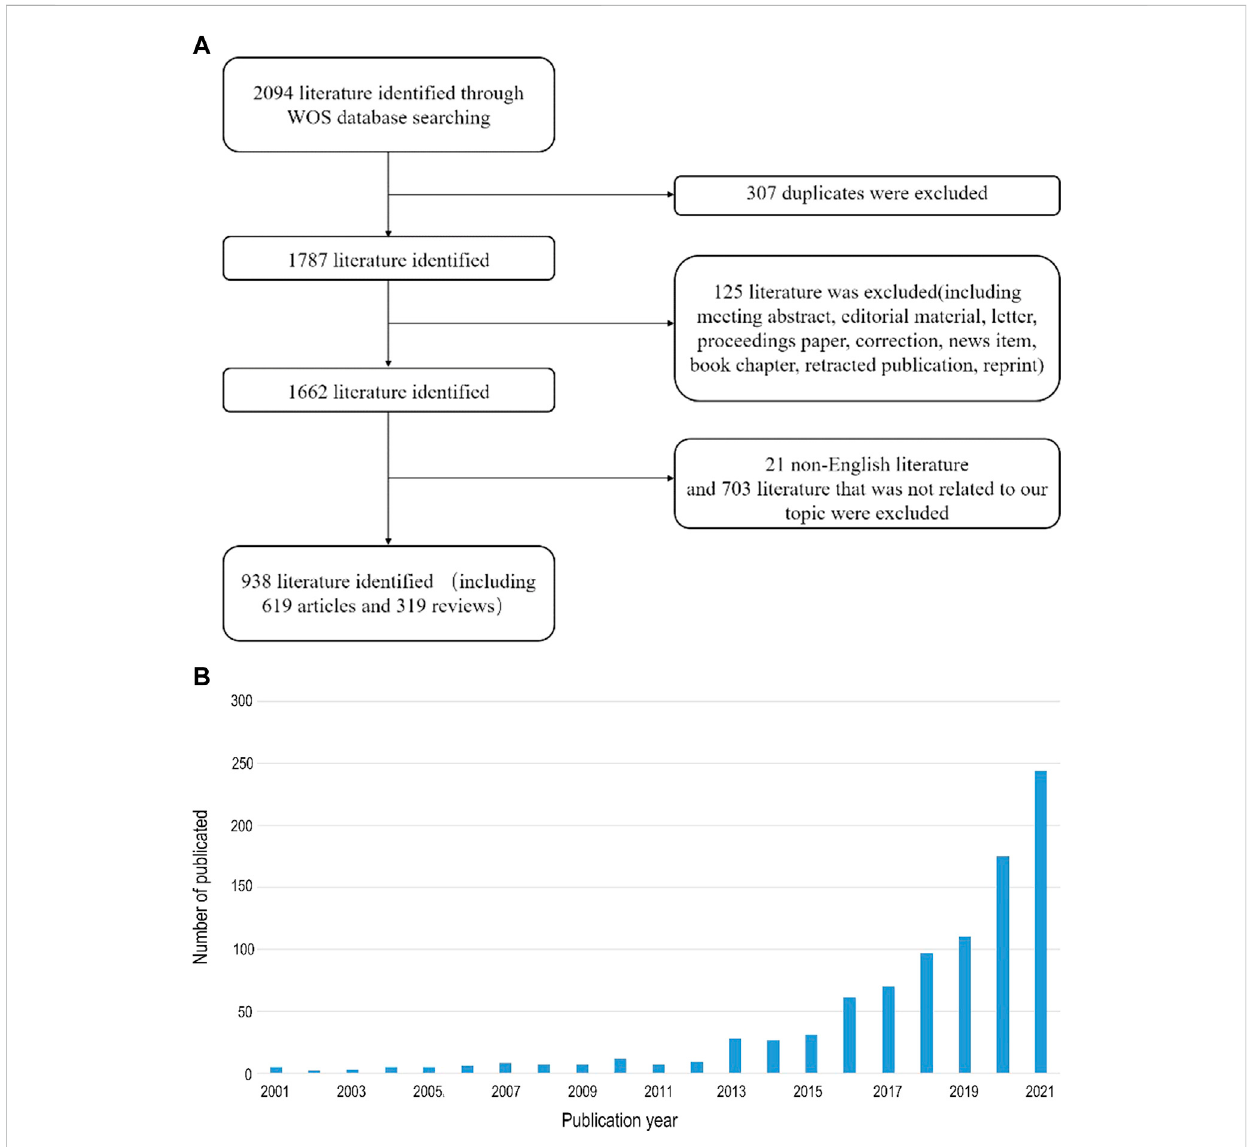
FIGURE 1 (A) Flow chart of screening 938 literature involved in our study. (B) Number of publications per year from 2001 to